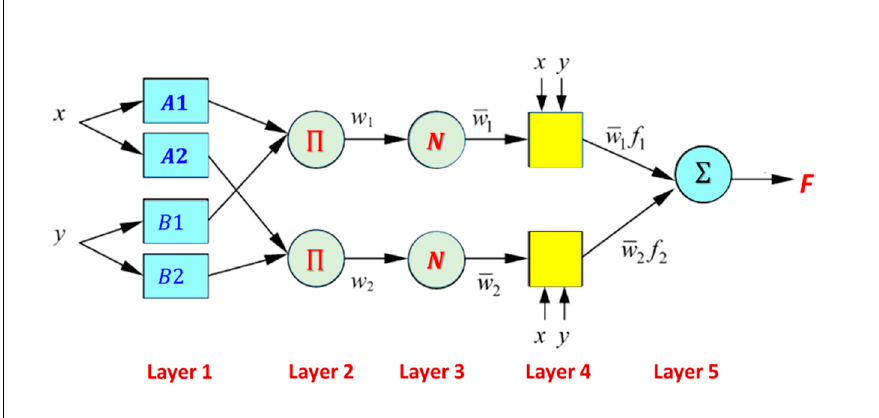
Figure 5. Basic structure of ANFIS with a two-rule Sugeno system.